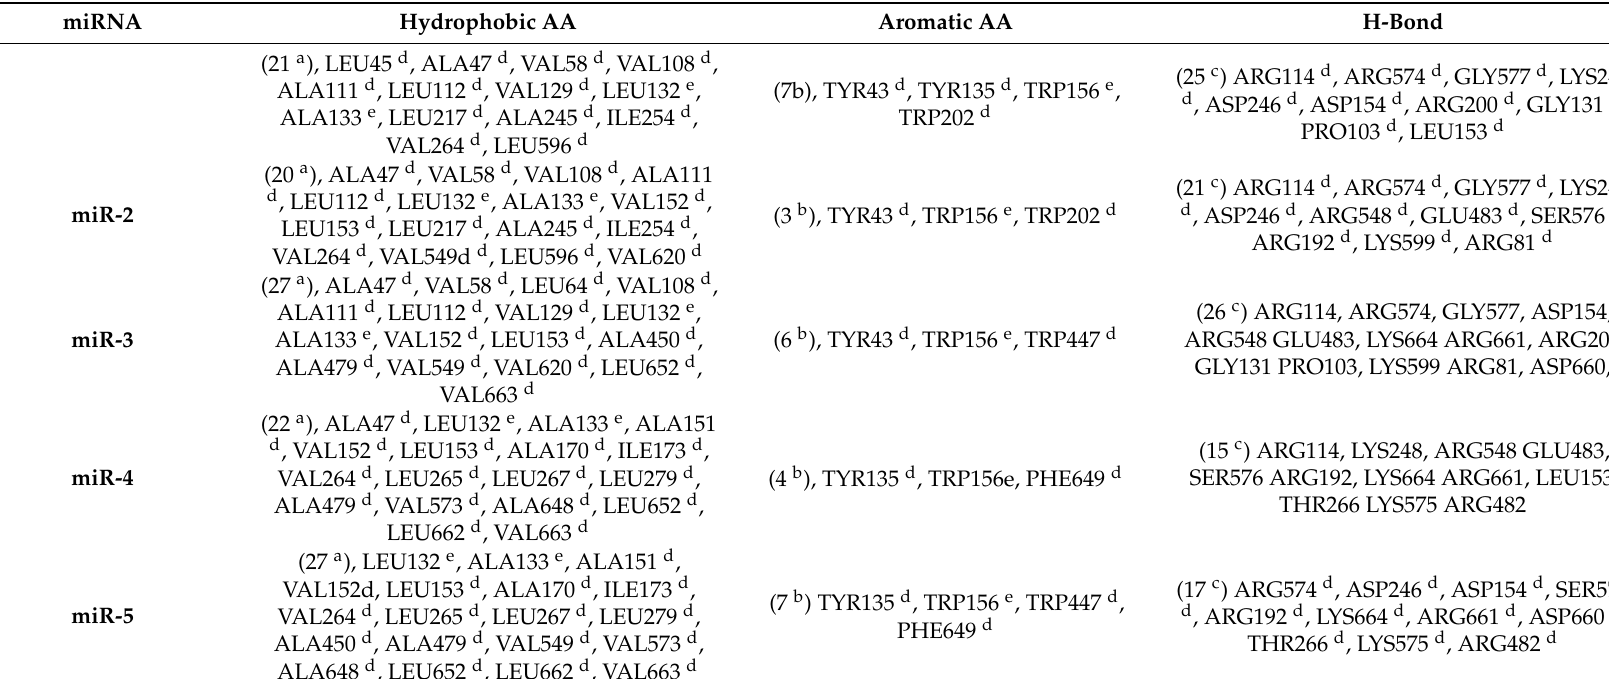
Table 7. Molecular docking analysis results of microRNA and receptors with participating aa residues (3.5 Å).